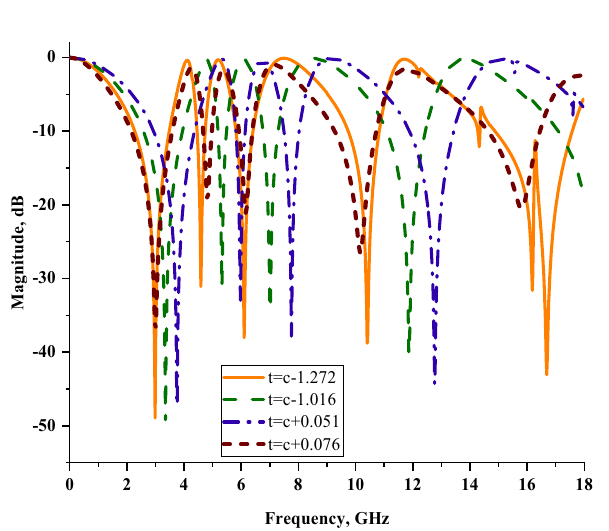
Figure 5. Reflection and transmission coefficients of several square metamaterial structures: ( a ) S11, ( b ) S21.